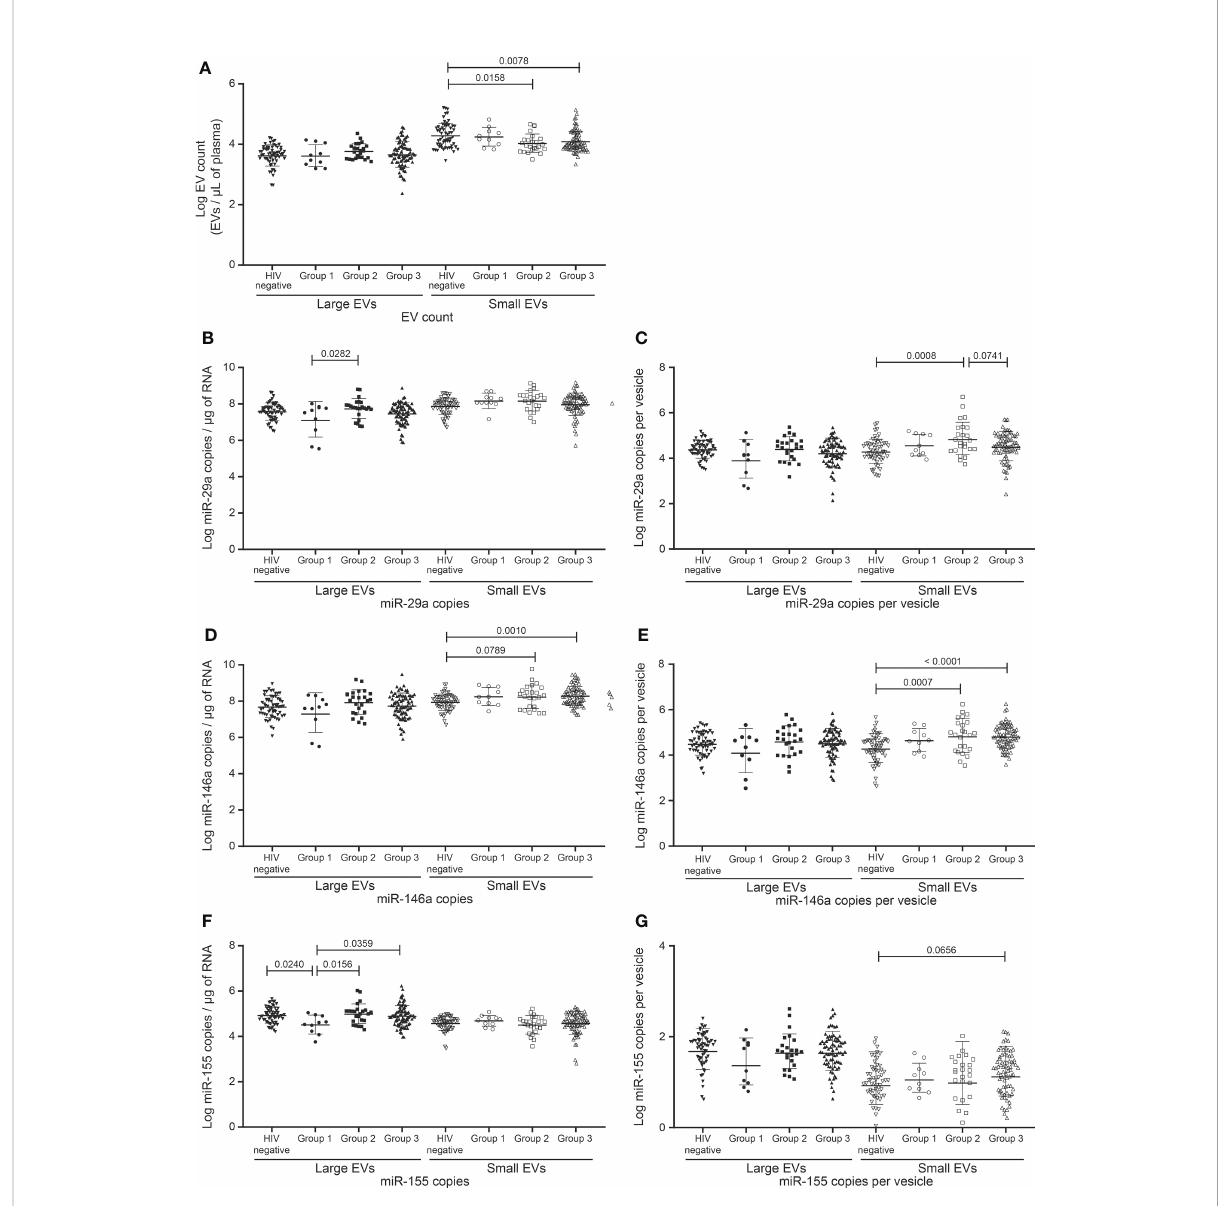
FIGURE 5 Change in the EVs count and miRNAs expression in study participants Follow a combination of undetectable viral load, CD8 T cell count, and CD4/CD8 ratio. HIV infected participants on ART for more than six months and with undetectable viral load (< 20 copies/mL) were divided into three groups. The reference group is characterized by participants with CD8 T cell < 500 cells/µL, CD4 T cell ≥ 500 cells/µL, and ratio CD4/ CD8 ≥ 1 (group 1, n=10). The second group is characterized by ratio CD4/CD8 ≥ 1 and CD8 T cell ≥ 500 cells/µL (group 2, n = 24), and the last group is characterized by ratio CD4/CD8 < 1 and CD8 T cell ≥ 500 cells/µL (group 3, n = 78). (A ) Large and small EVs particles number quanti fi cation in fl ow cytometry analysis. (B – E) , and (F, G) present respectively EVs miR-29a, miR-146a, and miR-155 quanti fi cation and expression as copies per µg of RNA and copies per vesicle. An ordinary one-way ANOVA with Tukey ’ s multiple comparisons test was used for comparison between